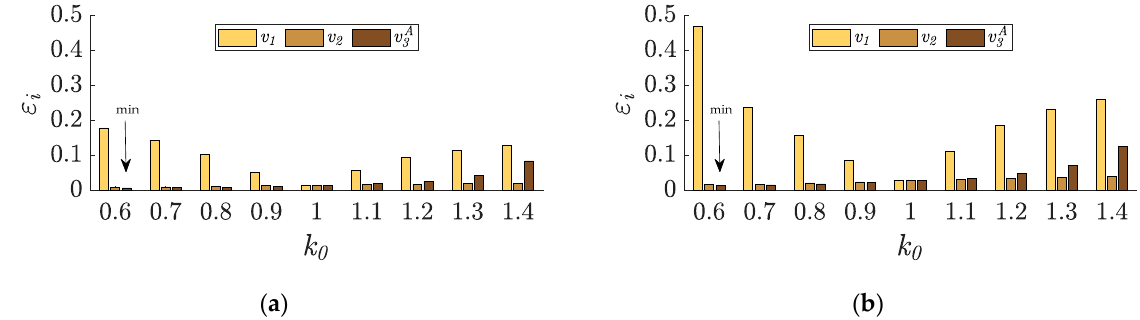
Figure 5. Error index of stator current estimation for ω m = ω mN and faulty CS in phase A : ( a ) t L = 0.25 t LN ; ( b ) t L = 0.75 t LN .